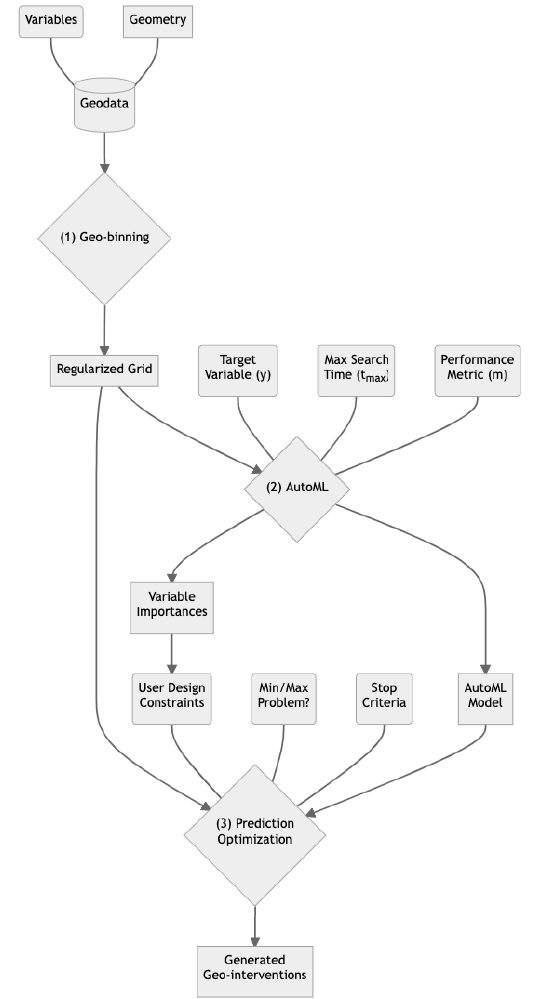
Figure 1 . Methods for Generating Geo-interventions.